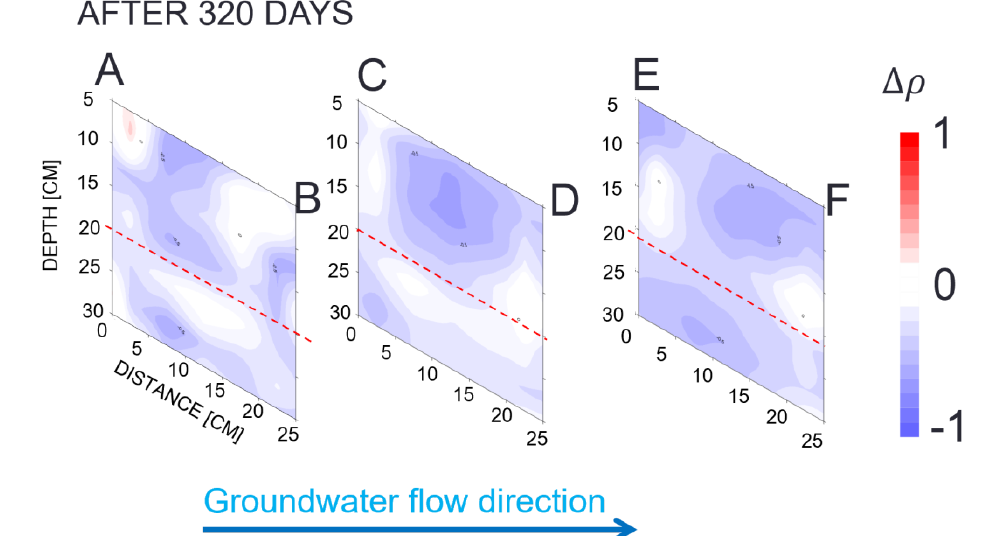
Figure 6. CHERTs obtained after 320 days from the contamination. The contamination generates evidence of conductive behavior for all the investigated sections.